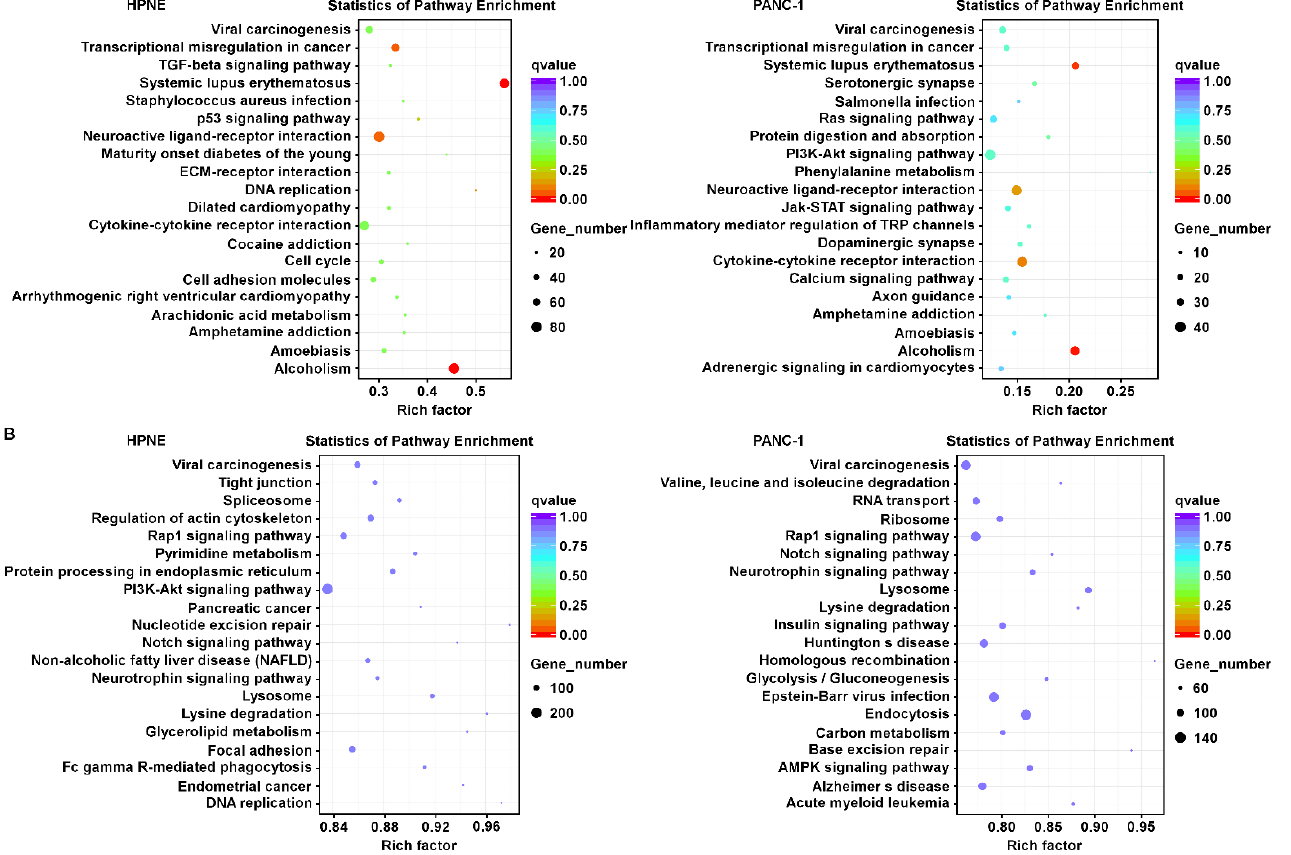
Figure 2. KEGG pathway enrichment analysis of differentially expressed genes and the differentially expressed lncRNA-colocalized genes. ( A ) Top 20 pathways revealed by KEGG enrichment analysis of differentially expressed genes induced by H 2 O 2 treatment in HPNE cells ( left ) and PANC-1 cells ( right ). The analysis was performed using KOBAS software. ( B ) Top 20 pathways revealed by KEGG enrichment analysis of genes whose DNA loci were colocalized with the differentially expressed lncRNAs (<100 kb) after H 2 O 2 treatment. In each diagram, the vertical axis shows the names of the pathways, and the horizontal axis represents the enrichment factor (the proportion of candidate gene relative to the background genes). The size of the dot represents the number of differentially expressed genes in the respective pathway, and the color of the dot indicates the Q value ranges.